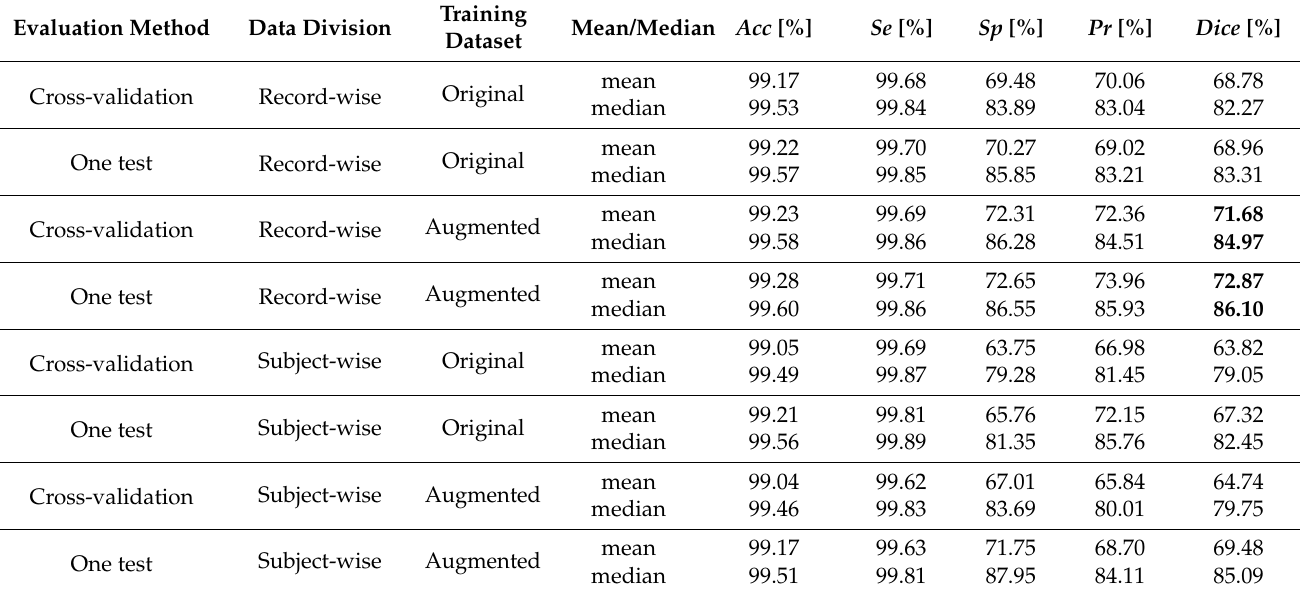
Table 3. Mean and median values of calculated coefficients for network